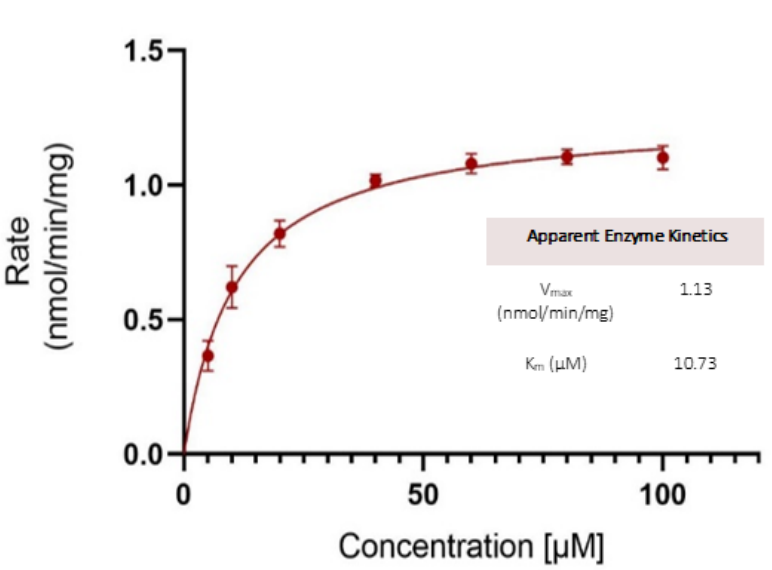
Figure 10. Apparent enzyme kinetics for OJT007 glucuronide.